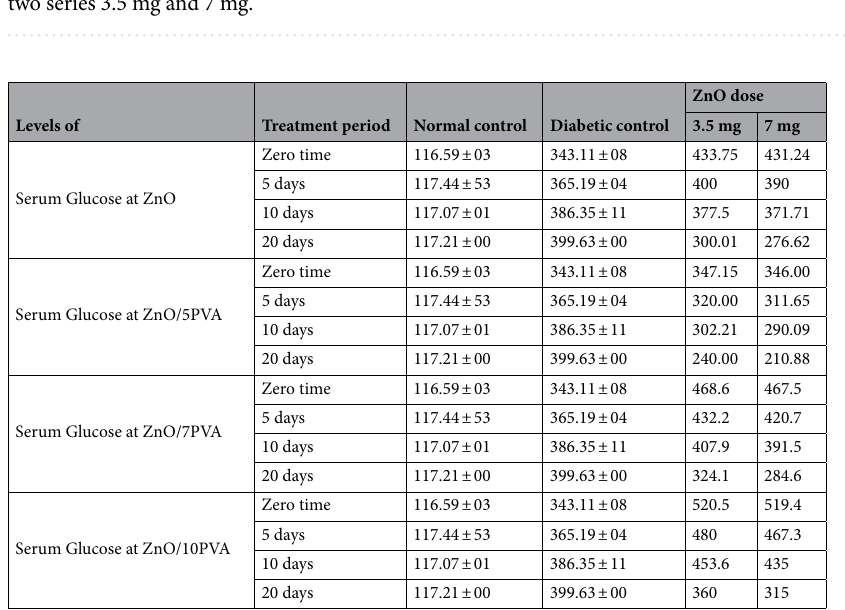
Table 2. Serum glucose level at different days and % of PVA for two series.